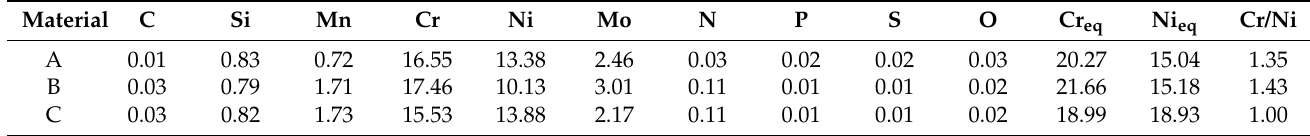
Table 2. Middle chemical compositions of the used materials in